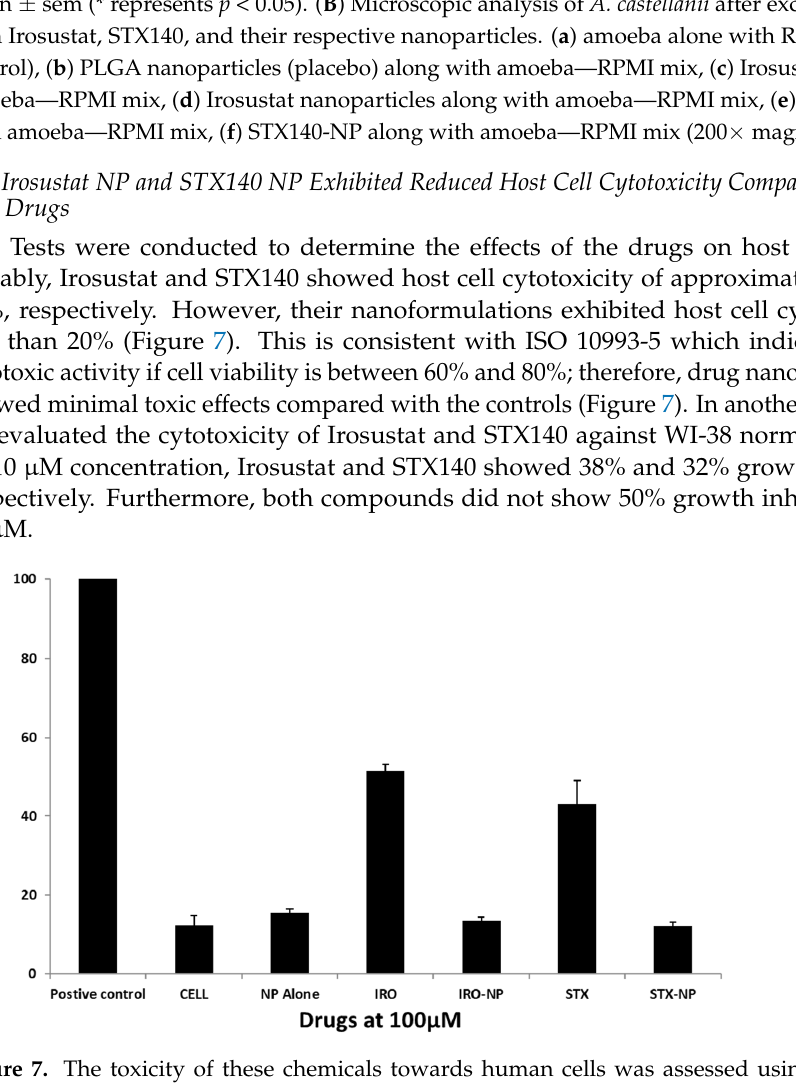
Figure 7. The toxicity of these chemicals towards human cells was assessed using cytotoxicity tests. All of the drugs used showed quite negligible cytotoxicity. The findings are shown as the mean ± sem.